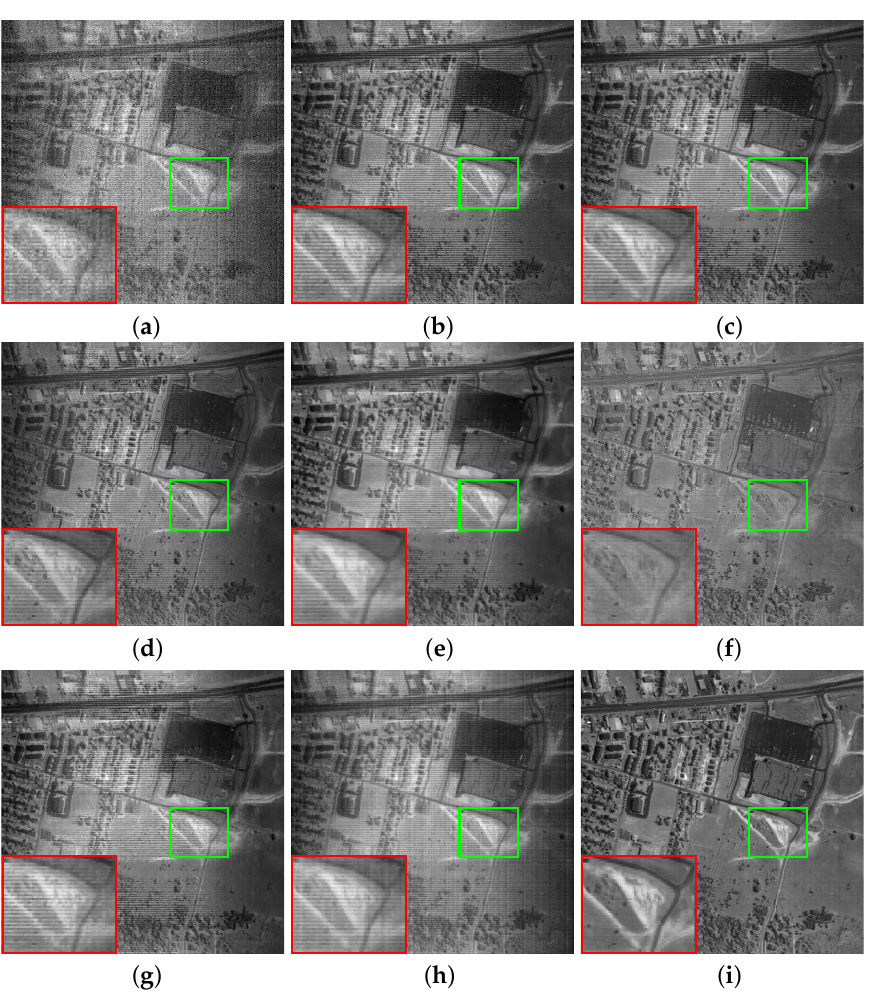
Figure 16. ( a ) Original image, image denoised by ( b ) LRTA, ( c ) BM4D, ( d ) LRMR, ( e ) LRTDTV,